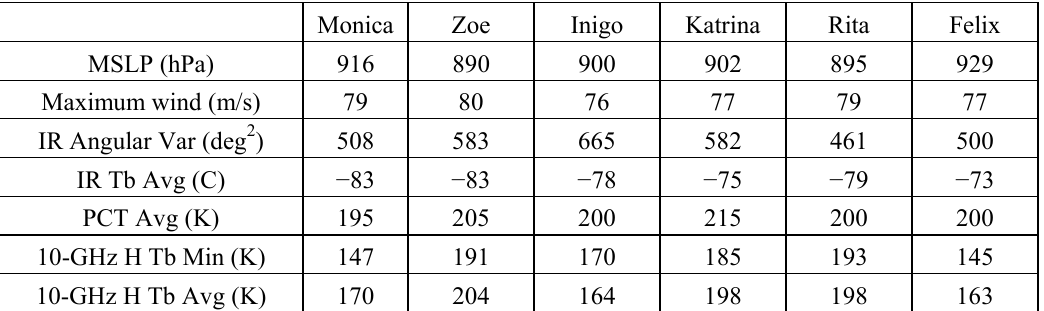
Table 4. Comparison of satellite observed parameters for Monica and several other intense cyclones at peak intensity. Maximum surface winds are 1-minute